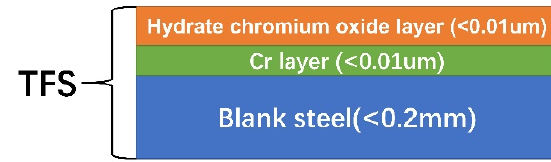
Figure 4. Polyethylene terephthalate (PET) molecular formula and model diagram (white is H atom, red is O atom, gray is C atom).